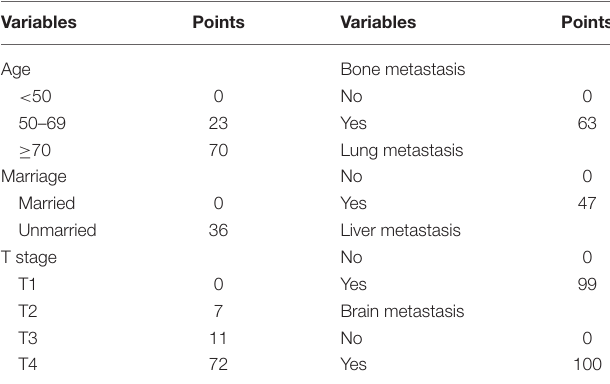
TABLE 3 | Scores of clinical variables in each